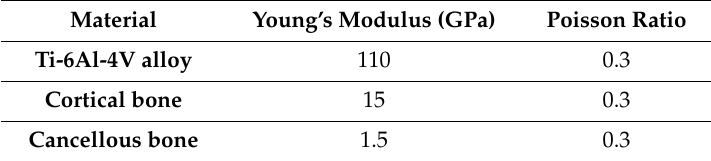
Figure 1. ( a ) Finite element model (unrepresented mesh) with boundary conditions and loading, ( b ) implant design: conical on the left and cylindrical on the right, ( c ) mandibular section: presentation of the four cortical thicknesses (1.0, 1.5, 2.0 and 2.5 mm) and ( d ) configuration of the implant in the bone (cutting in the vestibulo-lingual plane).